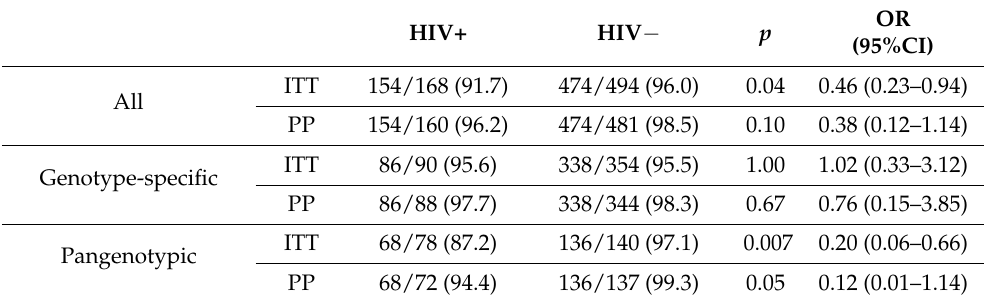
Table 4. Treatment effectiveness following genotype-specific and pangenotypic regimens according to the HIV